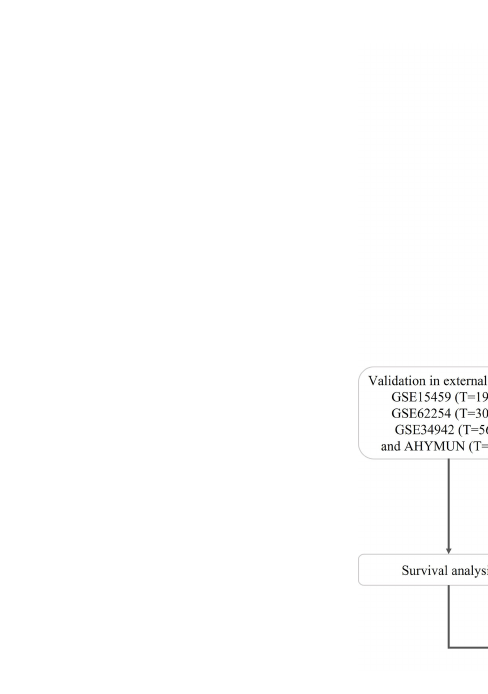
FIGURE 1 | Flowchart of the construction and validation of HP related